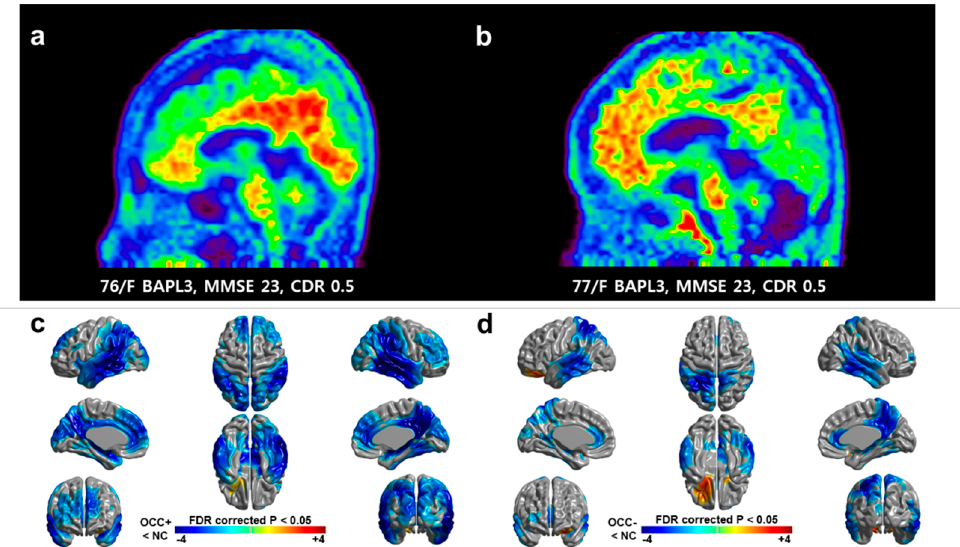
mild cognitive impairment; APOE, apolipoprotein E; MMSE, Mini-Mental State Examination; CDR, Clinical Dementia Rating scale; CDR-SB, Clinical Dementia Rating scale—Sum of Boxes; GDS, Global Deterioration Scale; GDepS, Geriatric Depression Scale. The data are shown as mean ± SD or n (%). *APOE genotyping was performed in 62 patients.